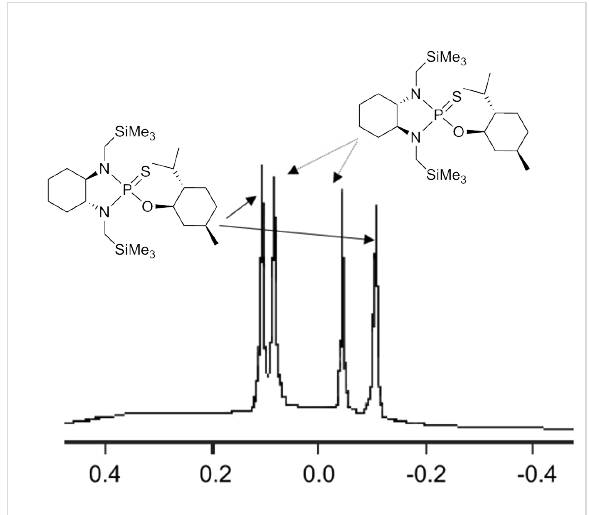
Figure 1: 1 H NMR spectrum in the -0.4↔0.6 ppm region of 2-(2-isop- ropyl-5-methyl-cyclohexyloxy)-1,3-bis-trimethylsilanylmethyl-octahydro- benzo [1,3,2] diazaphosphole